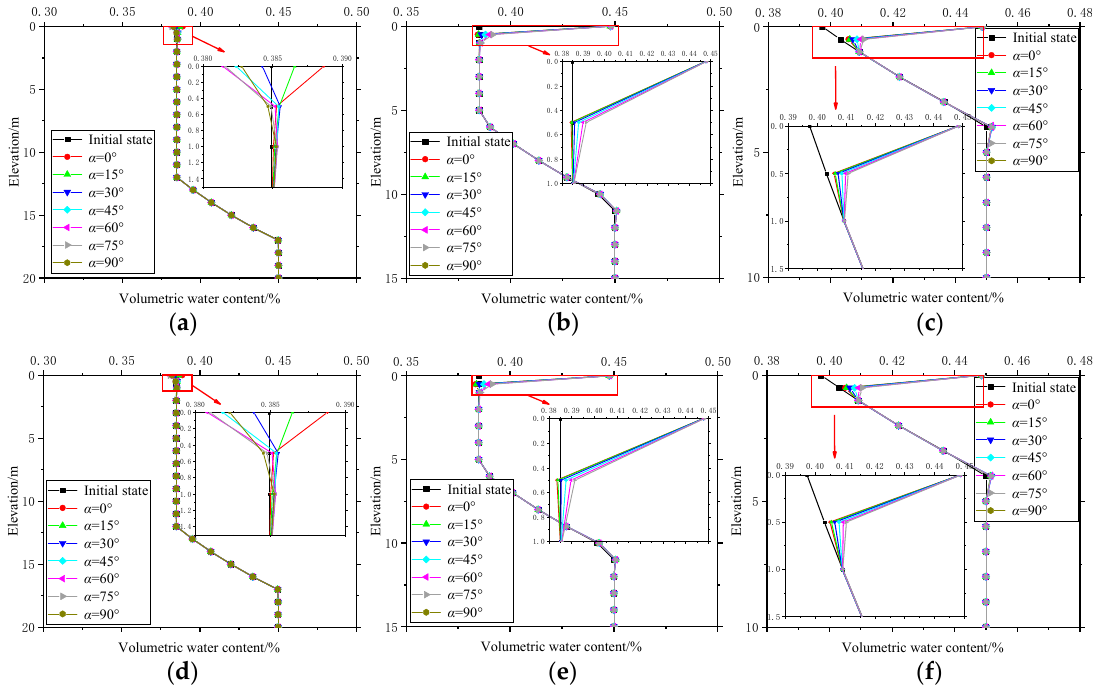
Figure 7. Variation of volumetric water content under different α values for clayey soil. ( a ) Top of the slope with k r = 10. ( b ) Middle of the slope with k r = 10. ( c ) Toe of the slope with k r = 10. ( d ) Top of the slope with k r = 100. ( e ) Middle of the slope with k r = 100. ( f ) Toe of the slope with k r = 100.